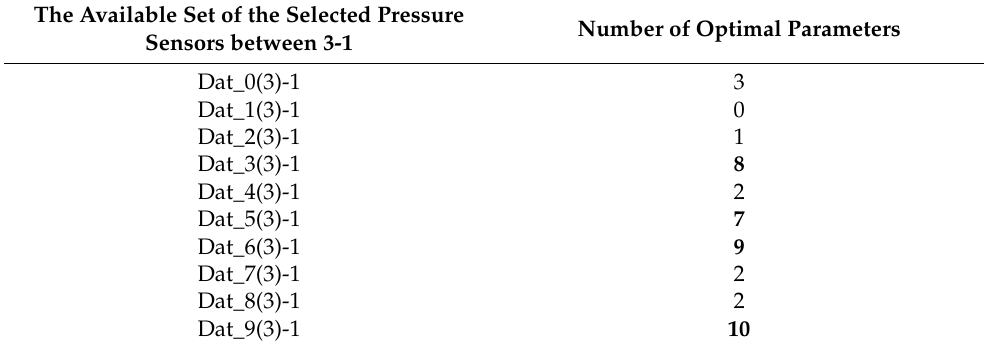
Table 8. The selection of the “best” sensor among sensors numbered 3. The sensor 1 is kept as the